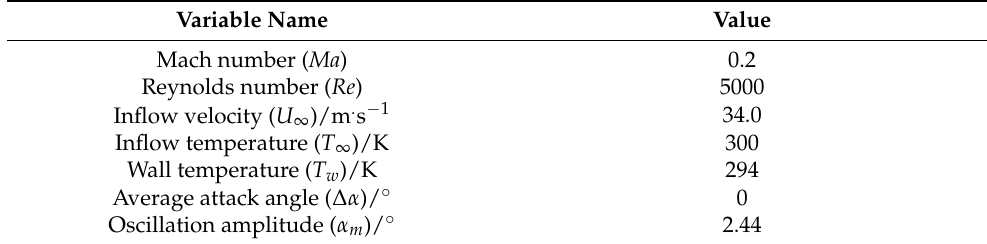
Table 1. Computational